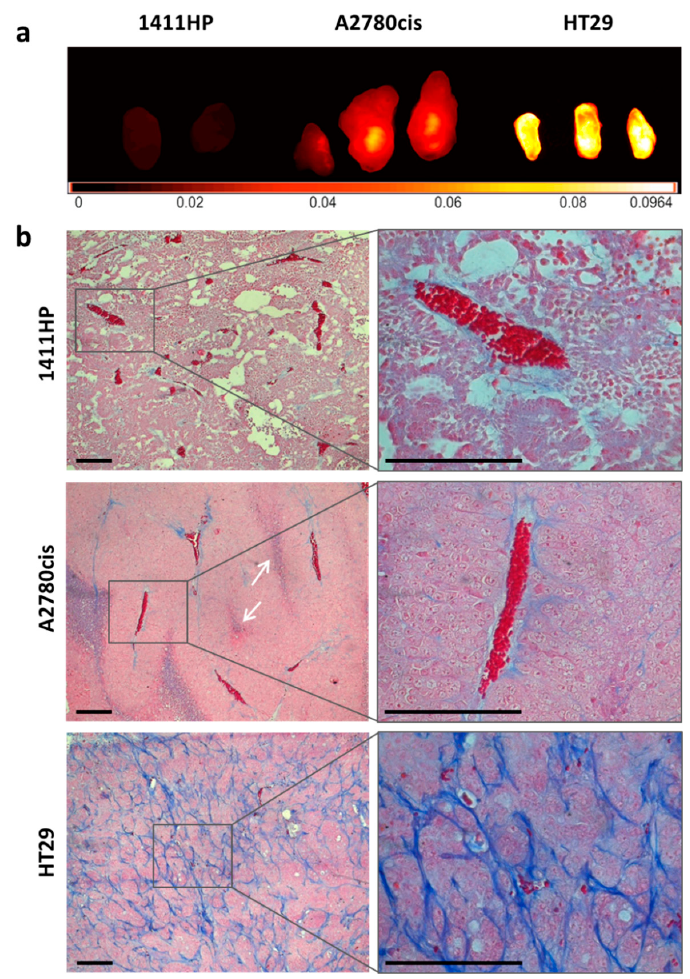
Figure 5. Characteristics of xenograft tumors. ( a ) Ex vivo imaging analysis of sliced tumors 24 h after injection of Hypoxisense ® indicating different microenvironments with most hypoxic/acidic conditions in HT29 tumors. ( b ) Azan staining of fixed tumor slides indicating different tumor